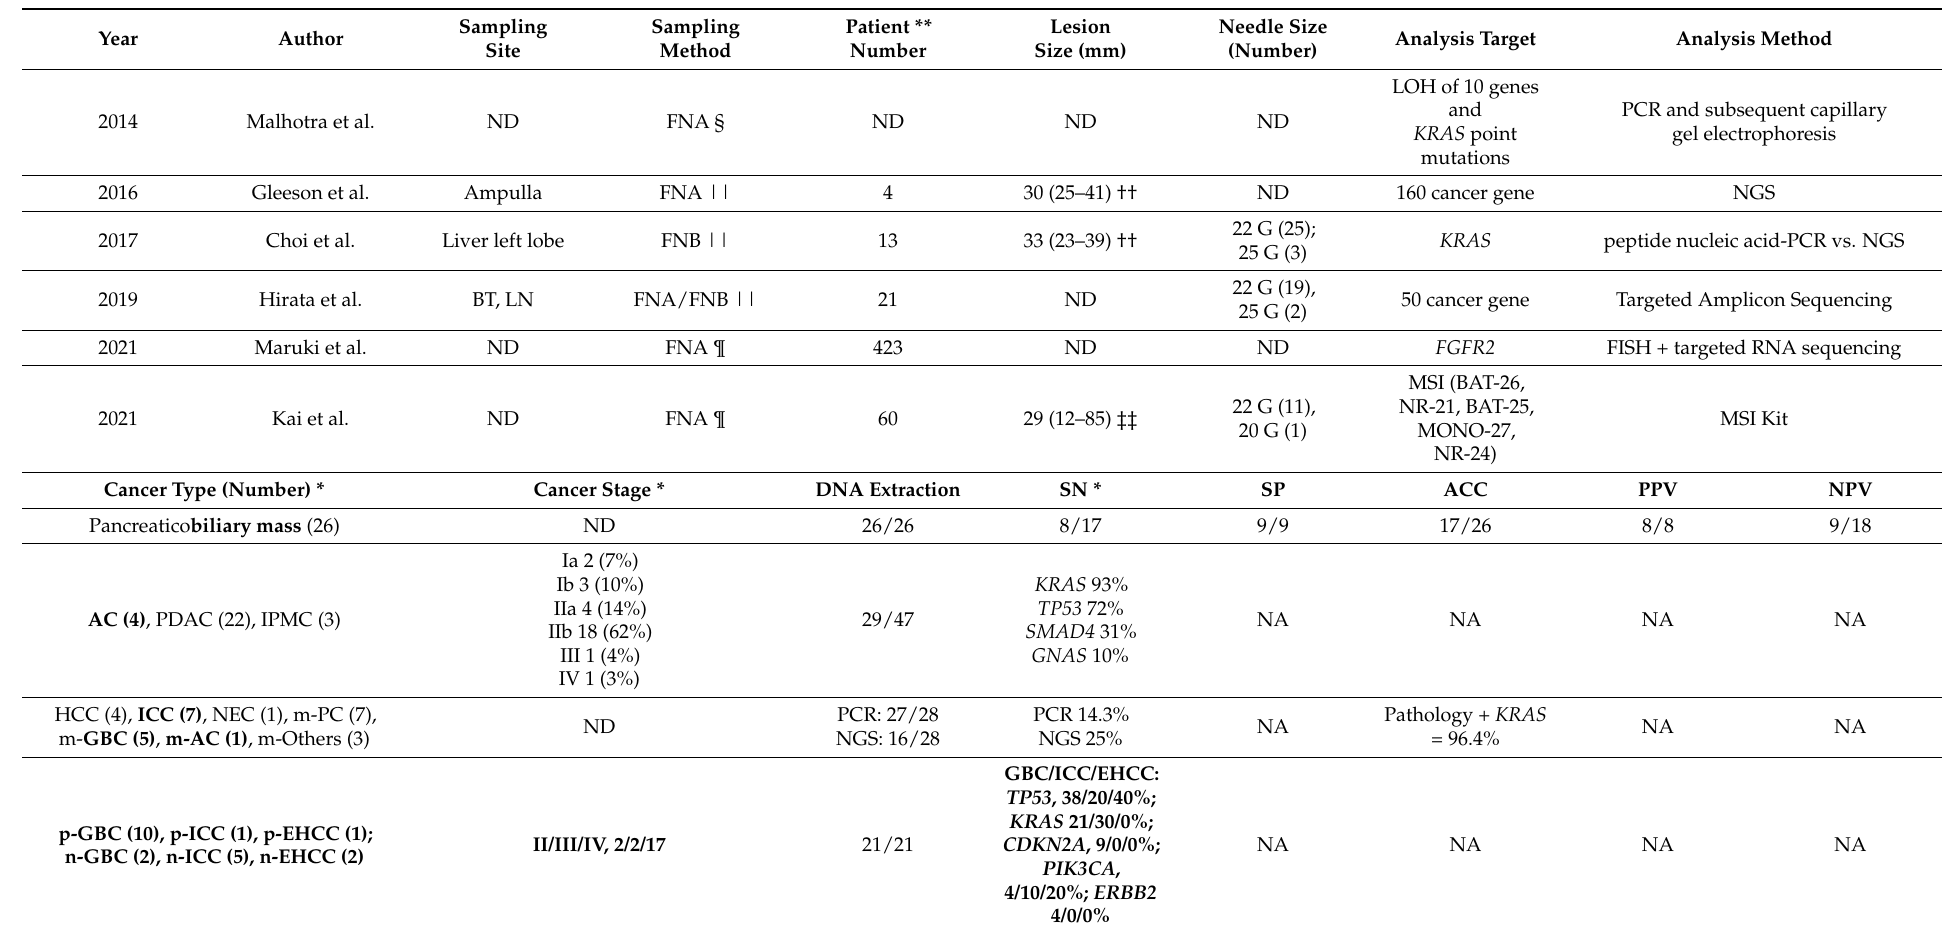
Table 1. Previous reports on genetic analysis with EUS-FNA/FNB specimens for biliary tract